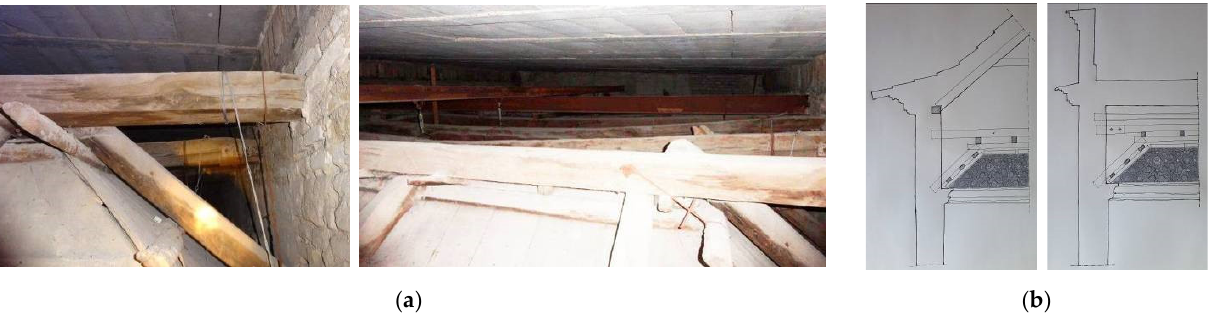
Figure 8. Hidden structural elements. ( a ) Anchorages of the 16th-century wooden beams on the wall/new metal girders and roof tie rods. Photographs by Ramón Queiro Quijada, 2016. ( b ) Schematic sections (hand drawn): hypothesis inclined roof of disappeared wood (left)/current state with new concrete slab and metal beams (right).